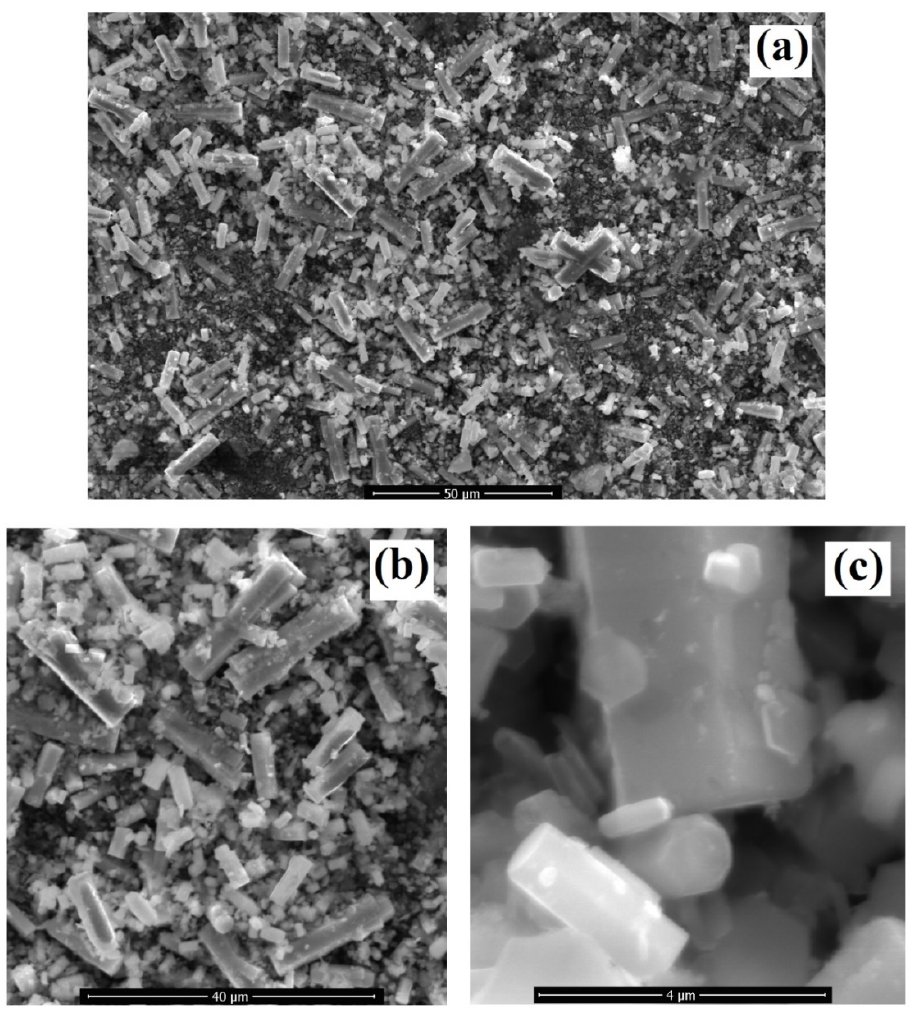
Figure 2. ( a ) Lower, ( b ) high, and ( c ) higher magnification micrographs of the as-synthesized Co- doped ZnO cylindrical microcrystals.